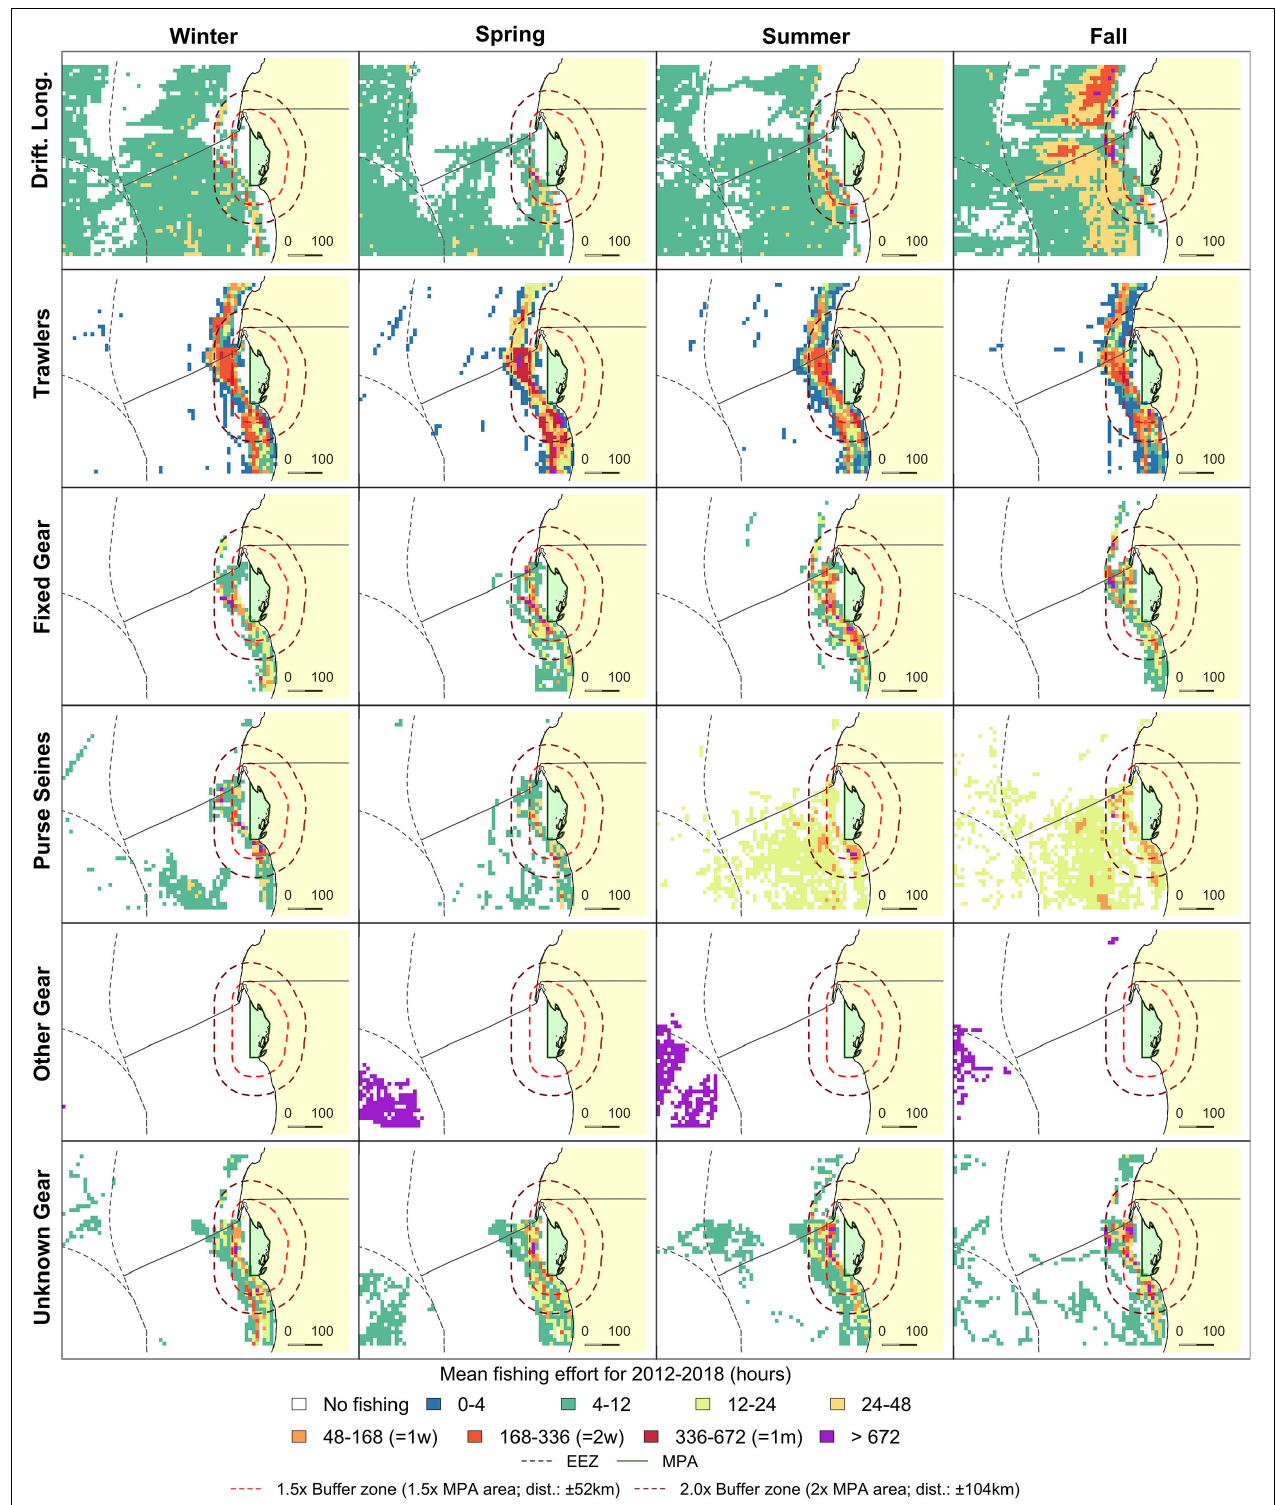
FIGURE 4 | Fishing effort in the direct vicinity of PNBA (green) in Mauritania. Grid cell colors indicate seasonal mean fishing effort over the 2012–2018 period. Orange and red dashed lines represent 1.5x and 2.0x buffer zones of the PNBA. Exclusive Economic Zones (EEZ) are indicated as gray dashed lines.